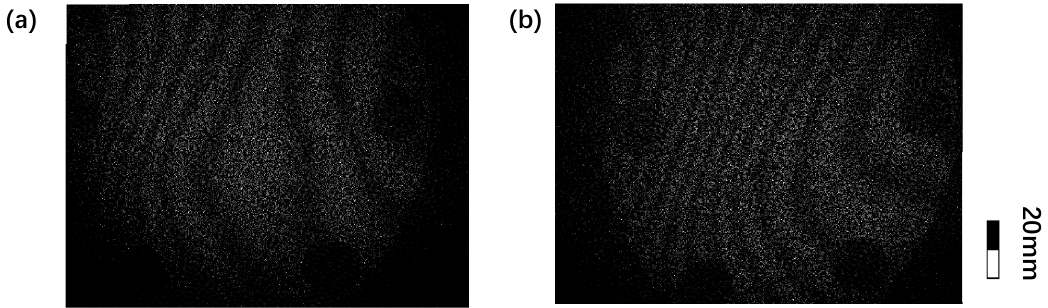
Figure 6. The speckle patterns and the fringe patterns generated by RP and WP: ( a ) the butterfly fringe patterns of RP; ( b ) the butterfly fringe patterns of WP.